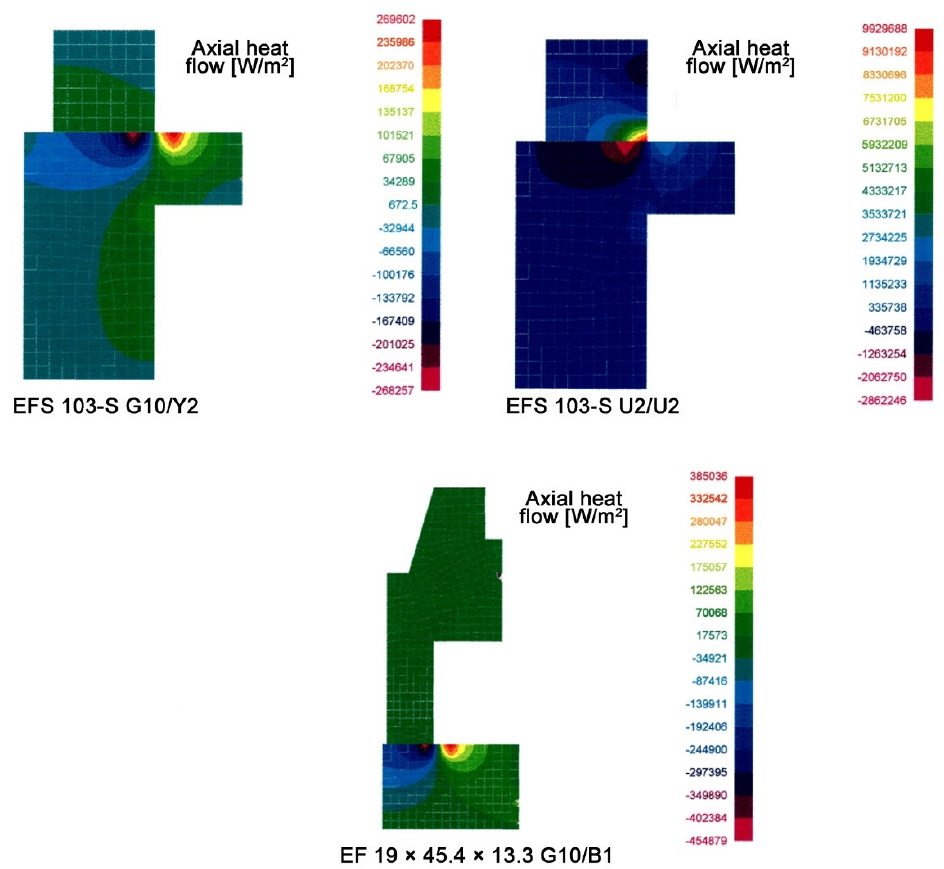
Figure 11. Axial heat flow results for MFS, EFS 103 − S, G10/Y2, U2/U2 and MFS, EF 19 × 45, G10/B1. After the postprocessing, the distributions of temperatures and the thermal loading along the interface of the primary sealing are also obtained (Figures 12–14).